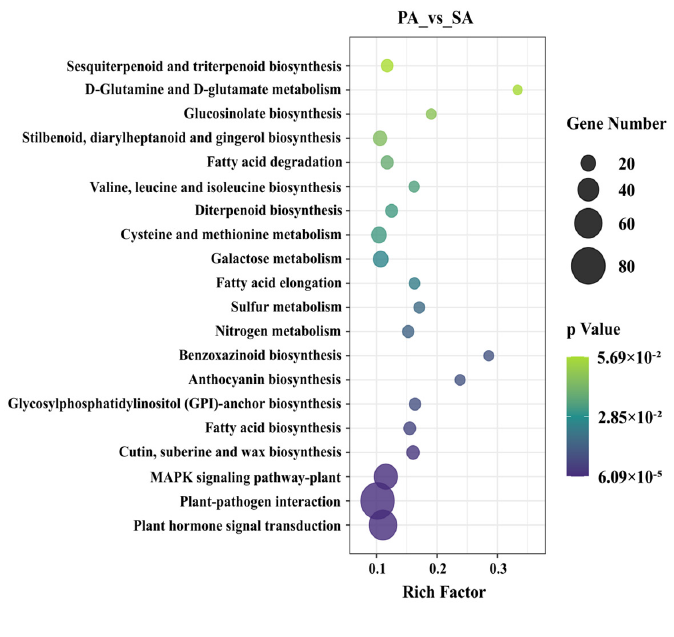
Figure 1. Statistics and Venn diagrams of differentially expressed genes (DEGs) in all samples. ( A ) Statistic diagrams of DEGs; ( B ) Venn diagrams of DEGs.